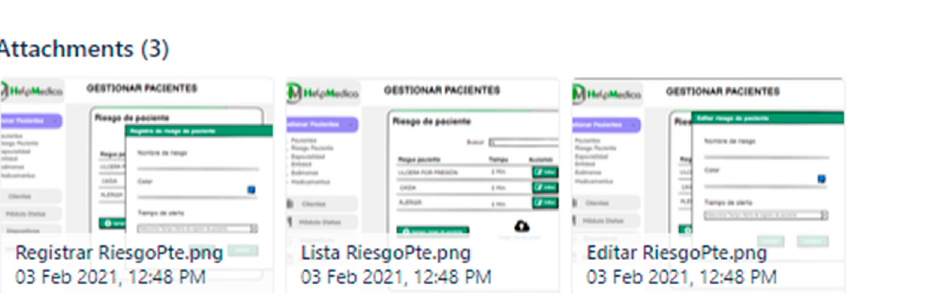
Figure 4. JIRA User Stories—Manage Patient Risk.